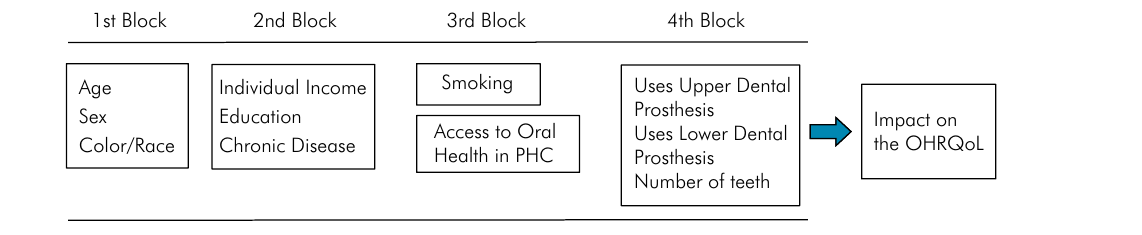
Figure. Theoretical model used in the